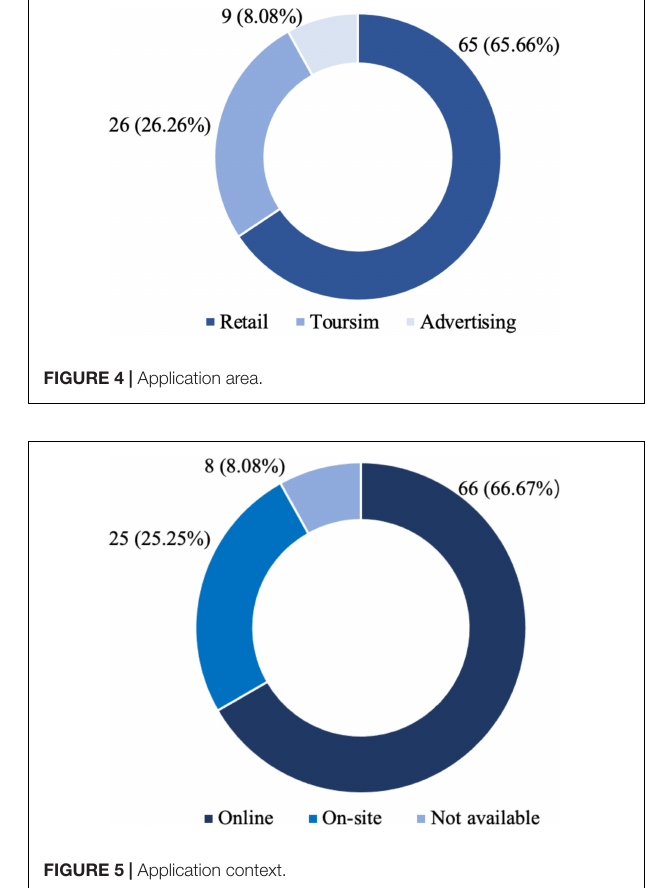
FIGURE 5 | Application